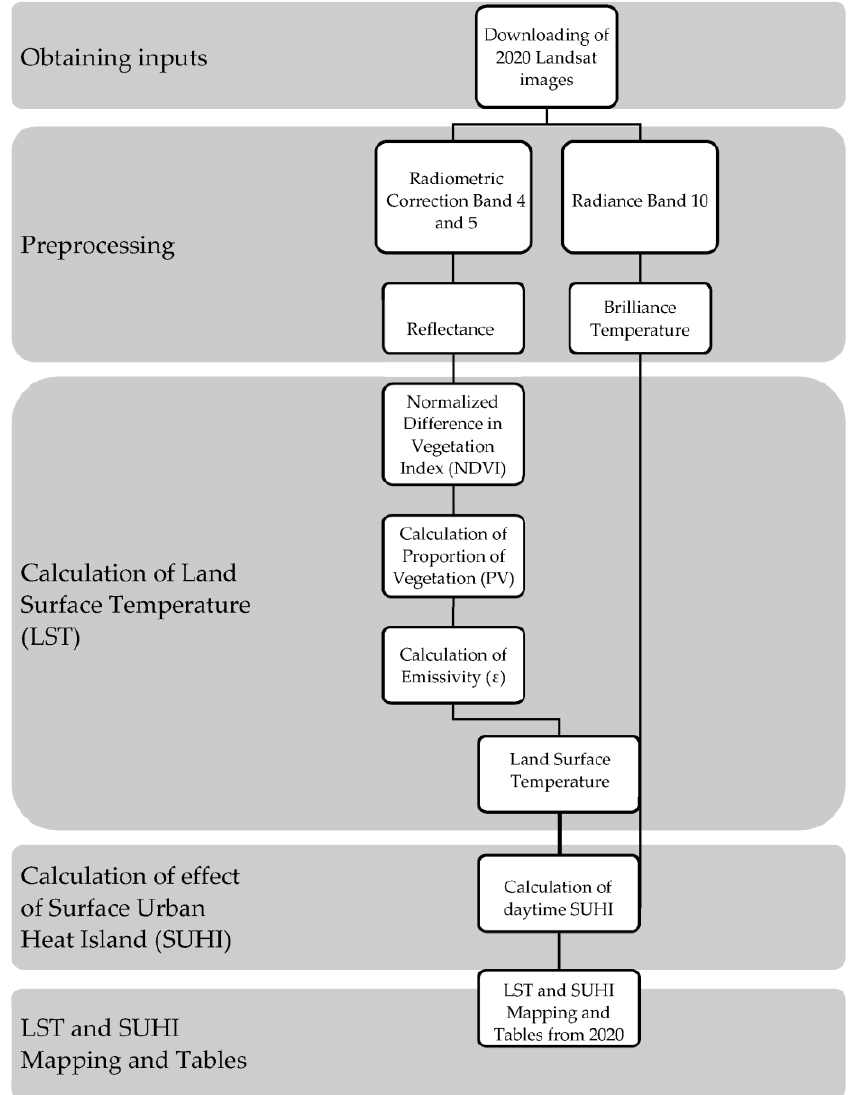
Figure 2. Methodology for Obtaining Daytime LST and SUHIs from Landsat 8 Satellite Images. Obtaining inputs: As depicted in Table 1, the Landsat products were downloaded from the EarthExplorer platform. The search criteria used to download the dataset for this Agua (Comisión Nacional del Agua, Spanish acronym, CONAGUA, 2020) database [31]. Where it is observed that the hottest months corresponding to the Baj í o area are April and May, thus selecting the images closest in time and best visualized, i.e., with little or no cloud cover. The acquired data belong to level 1, which are orthorectified products.